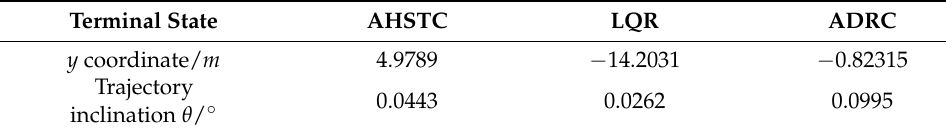
Figure 6. Control tracking curve. Table 2. Tracking error based on Simulation Analysis 1.